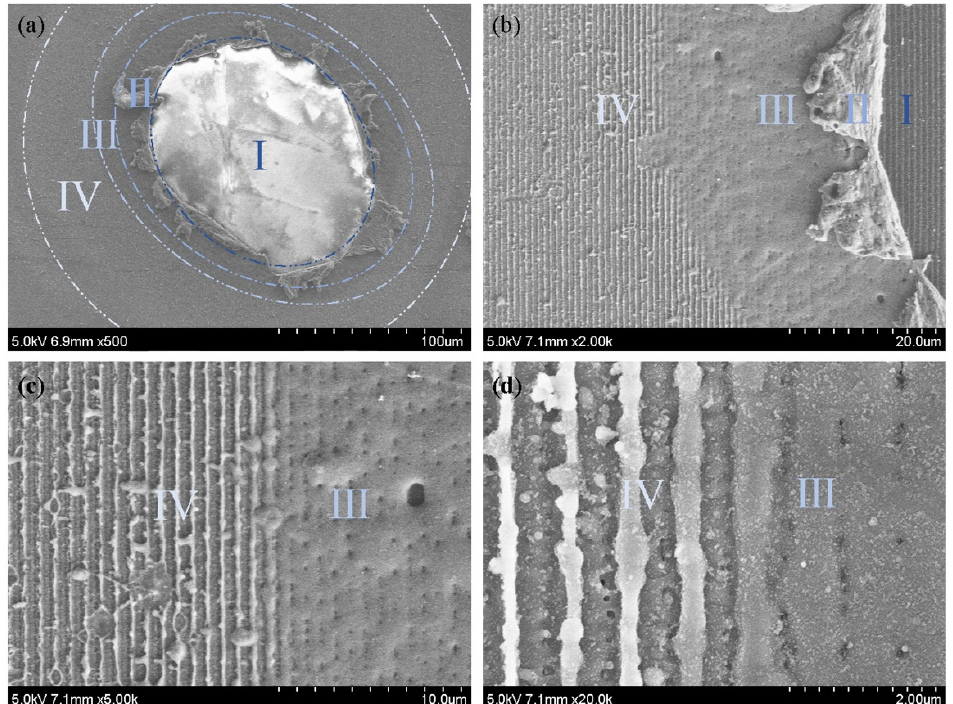
Figure 5. Thermal ablation melting damage morphology of aluminum grating at 325 J/cm 2 ( a ) 500×; ( b ) 2000×; ( c ) 5000×; ( d ) 20,000×.